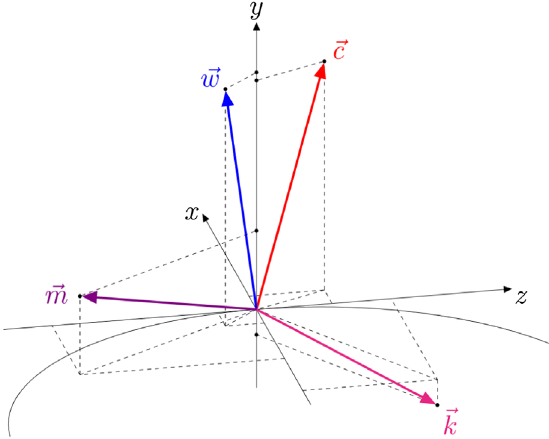
⃗ ⃗ k ∝ ð ⃗ c × ⃗ w Þ and ⃗ m ∝ ð k × ⃗ c Þ ,